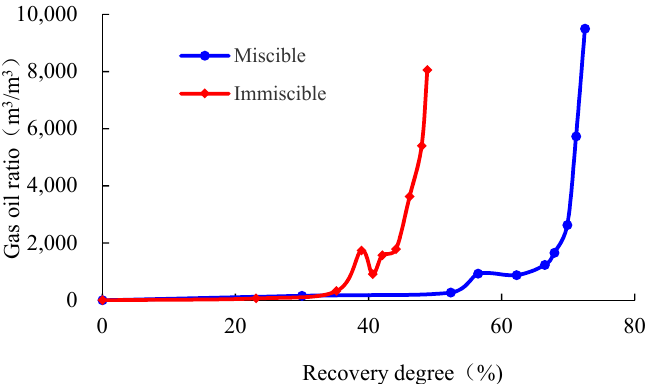
Figure 3. The relationship between recovery degree and gas–oil ratio (0.892 mD core).